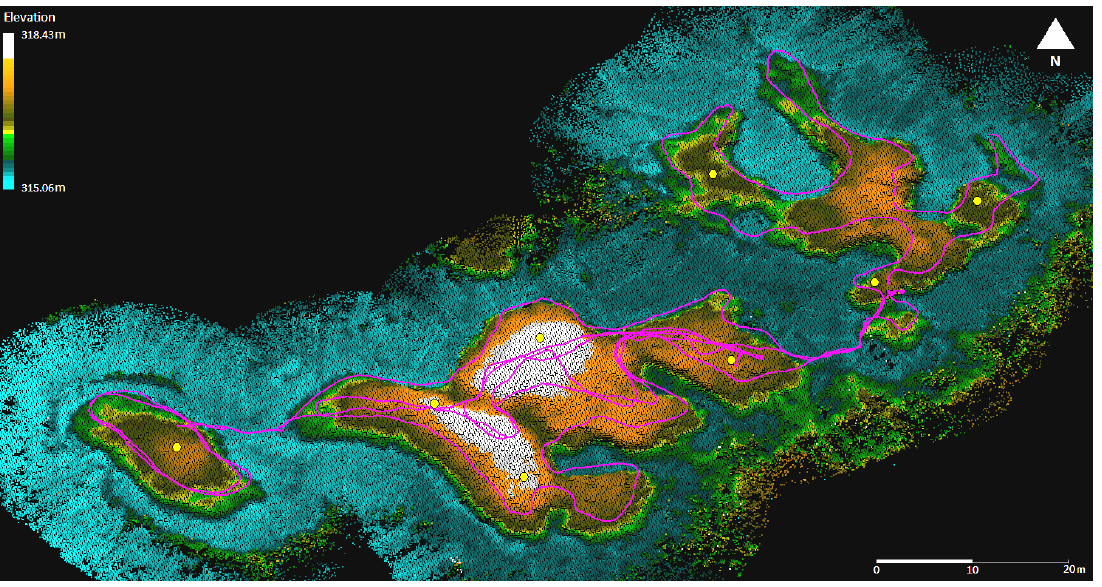
Figure 11. An elevation model with a 20 cm grid size of Vaisjeaggi permafrost palsa landform surveyed with an Akhka backpack MLS in June 2011. The survey trajectory is represented by purple lines and the control spheres by red